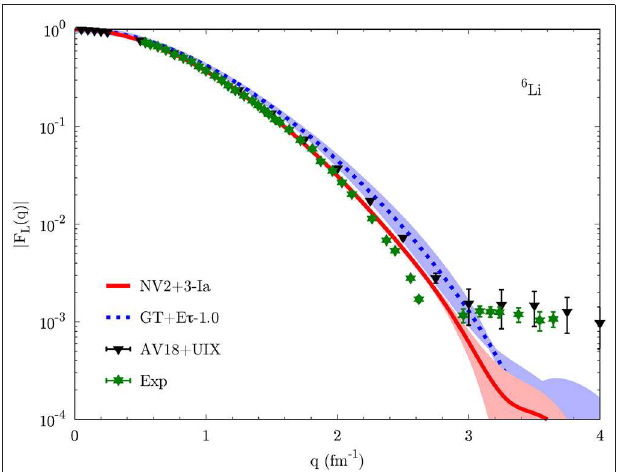
FIGURE 7 | Longitudinal elastic form factor in 6 Li for different nuclear potentials. For the NV2+3-Ia (solid red line) and AV18+UIX (black triangles) potentials, errors correspond to statistical Monte Carlo uncertainties. The blue band for the GT+E τ -1.0 potential also includes the uncertainties coming from the truncation of the chiral expansion. Green stars are the experimental values [131]. Adapted from reference [89].